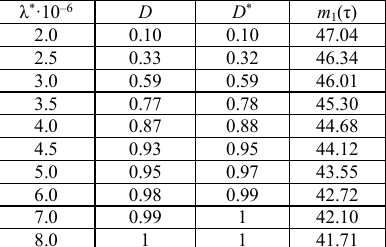
E FFICIENCY C ALCULATION R ESULTS FOR K = 20